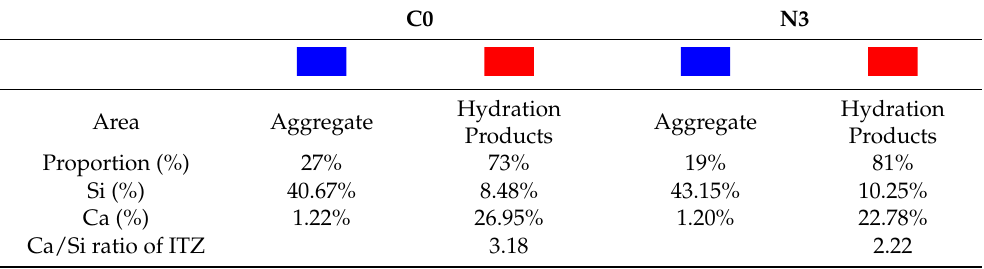
Figure 20. BSE-EDS analysis of ITZ of ( A ) C0 and ( B ) N3 at 28 days. Table 7. Analysis of the element content of ITZ of different mortars.